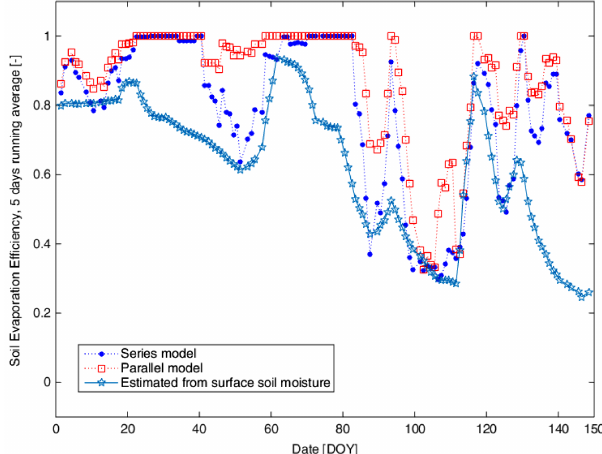
Figure 10. Evolution of the retrieved evaporation efficiencies com- pared to the simulated evaporation efficiency computed using ob- served surface soil moisture time series for the rainfed wheat site.